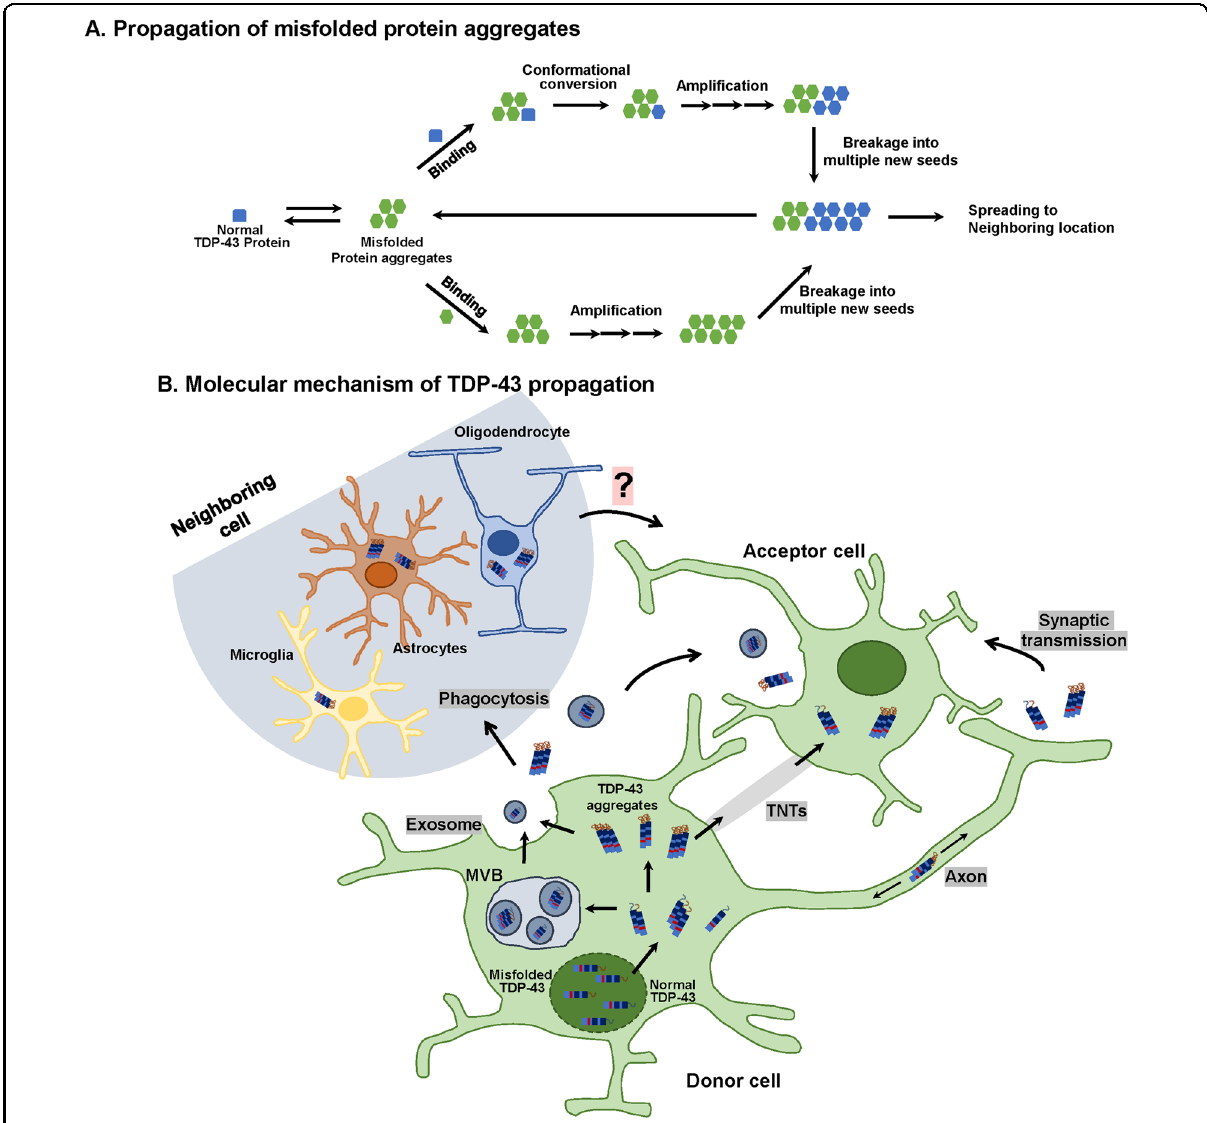
Fig. 2 Schematic overview of misfolded TDP-43 propagation in TDP-43 proteinopathies. a Proposed mechanism of self-propagation of misfolded TDP-43 in TDP-43 proteinopathies. Misfolded TDP-43 aggregates bind to their normal counterparts and induce the misfolding of bound protein in a template-dependent manner. This process leads to the elongation of misfolded TDP-43 aggregates. Ampli fi cation of self-templating amyloid fi brils results from the fragmentation of TDP-43 aggregates, which exposes new ends. b Putative mechanism of cell-to-cell spreading of TDP- 43 aggregates. TDP-43 aggregates may propagate via exosomes (release from multivesicular bodies (MVBs)), tunneling nanotubes (TNTs), or synaptic transmission (transport from presynaptic to postsynaptic terminals) from donor cells to acceptor cells. Moreover, glial cells (oligodendrocytes, astrocytes, and microglia) can take up TDP-43 aggregates through phagocytosis, after which misfolded TDP-43 is released from glial cells and transmitted to neurons and neighboring glial cells. The neuron-to-glia or glia-to-neuron transfer of TDP-43 has been observed, but its propagation mechanism is not